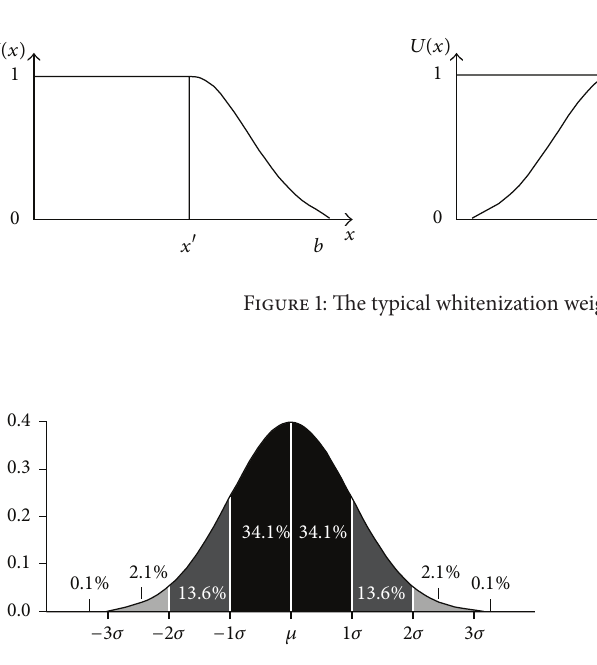
Figure 2: Value distribution of normal